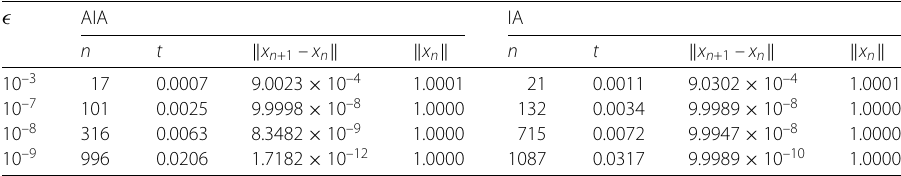
Table 2 Comparison of Algorithm 3 (AIA) with Algorithm 1 (IA) for Example 4.2. u = e t , x 0 = t , x 1 = t 2